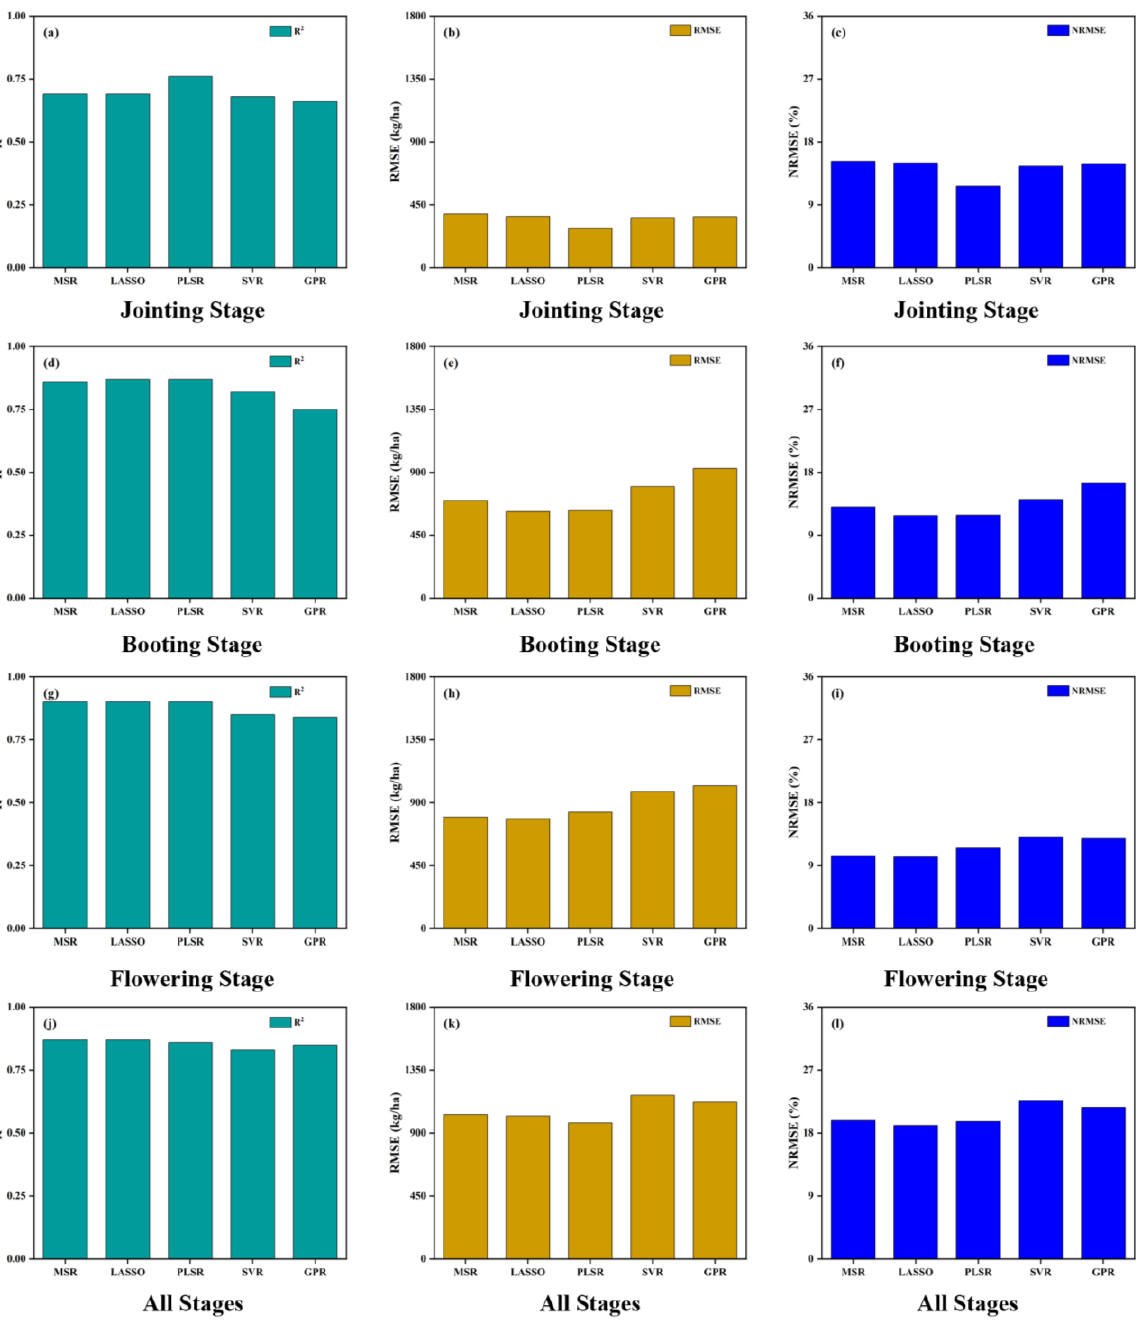
Figure 7. Results of the AGB estimation based on CIS + PH at ( a – c ) jointing stage, ( d – f ) booting stage, ( g – i ) flowering stage, ( j – l ) all stages.